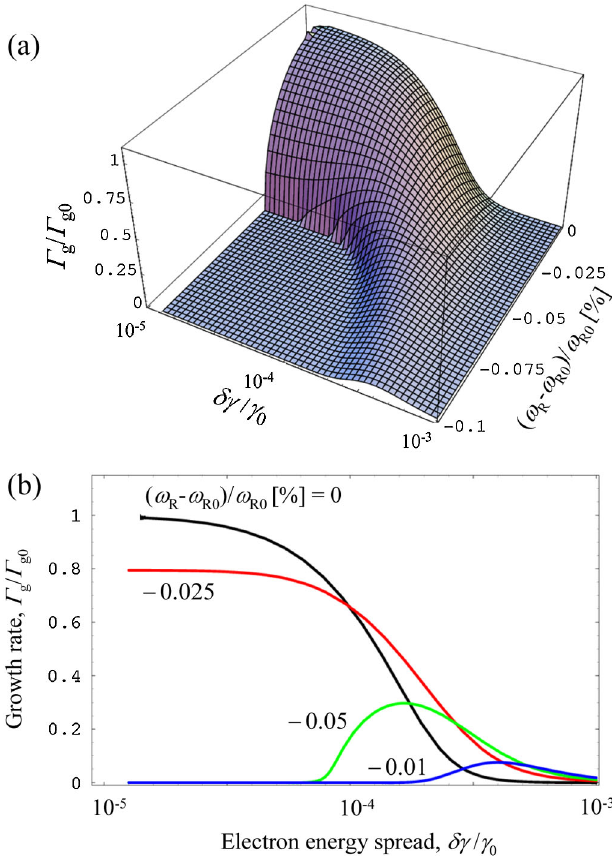
FIG. 3. (Color) (a) Surface plot of normalized x-ray growth rate = (cid:2) from Eq. (8) versus fractional electron beam energy (cid:2) g go spread (cid:8)(cid:6)=(cid:6) and fractional detuning ð ! (cid:4) ! o parameters of the laser-pumped FEL of Table I. (b) Line plots of = (cid:2) versus (cid:8)(cid:6)=(cid:6) for various values of detuning for the (cid:2) g go o same data as shown in Fig.